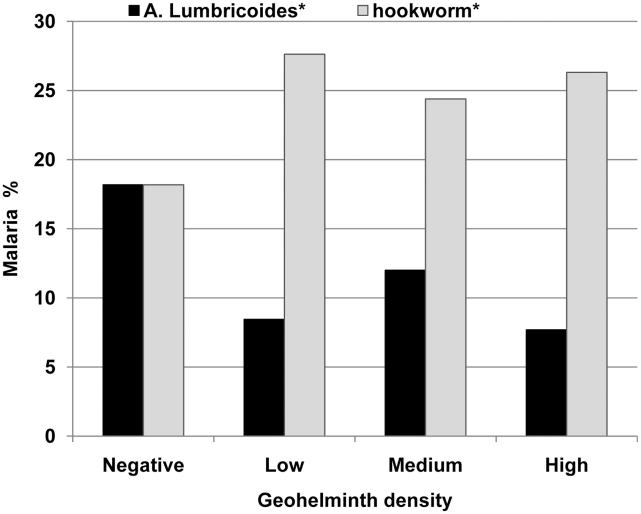
The proportion of women with malaria by density of geohelminth.Footnote: Low, medium and high defined as >0–499, 500–999, ≥1000 ova/ml for hookworm and 1–3, 4–10, >10 ova per slide for A. lumbricoides, respectively. *  =  +/− Trichuris trichuria.